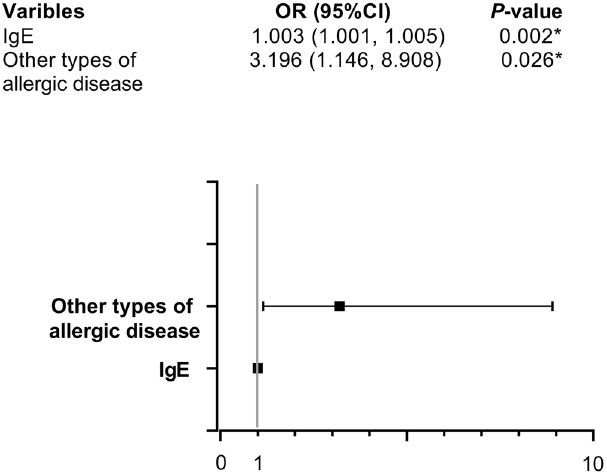
Figure 3. Multivariate analysis of logistic regression of IgG4-RD patients complicated with AR/CRS (Case group). High IgE level and other types of allergic disease were risk factors for patients complicated with AR/